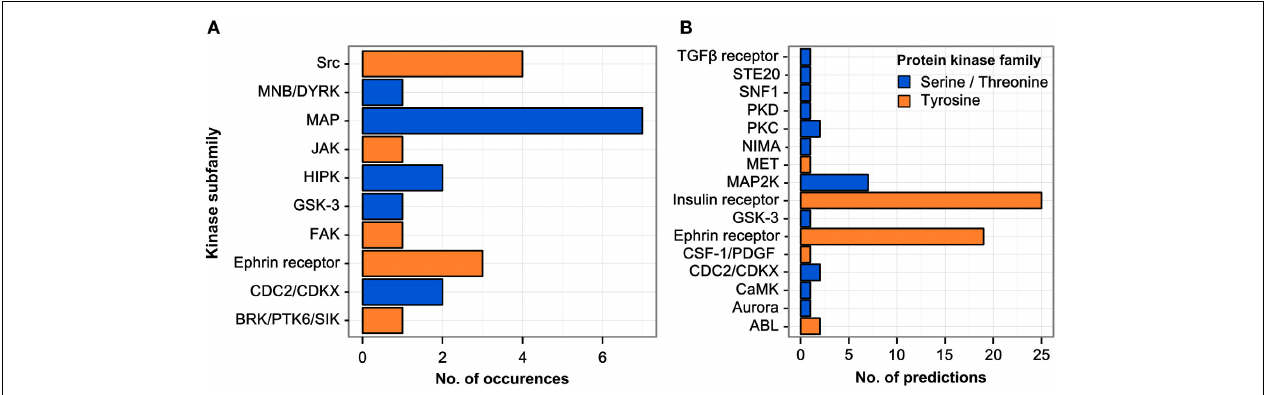
FIGURE 2 | Regulated kinase families identified and predicted acting/upstream kinase families responsible. (A) Kinases which were identified among the regulated phosphopeptides were sorted according to their respective kinase subfamily. Only hits with a log2 SILAC ratio > ± 0.5 were included. MAP kinases are the most abundant kinase subfamily